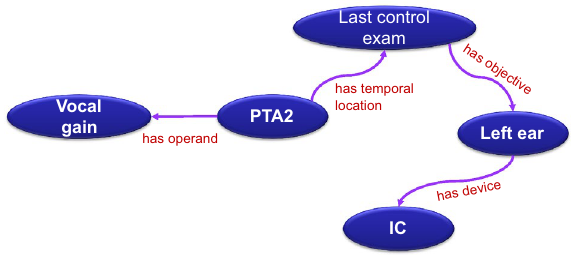
Figure 4. Modeling of a complex property: the possible logical decomposition of the complex property “Pure tone average of vocal gain during last control exam with intracochlear device on left ear”. Conceptually, an unstructured text representing the property in the database would expand to a set of logical clauses that can be queried and summarized in Prolog [Created with Inkscape 1.1.2 (b8e25be833, 2022-02-05) by the first author; https:// inksc ape.